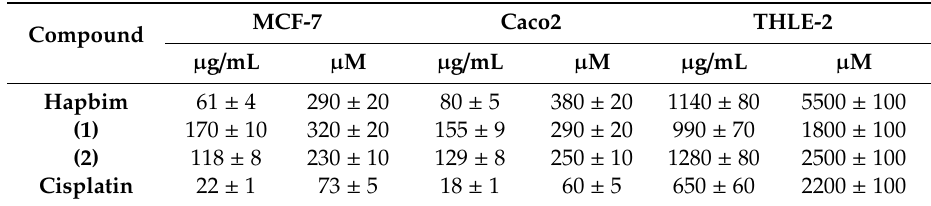
Table 2. In vitro cytotoxicity given as IC 50 in µ g / mL and µ M of Hapbim and complexes ( 1 ), ( 2 ), and cisplatin against human breast cancer (MCF-7), human colorectal cells lines (Caco2), and normal liver cell line (THLE-2).